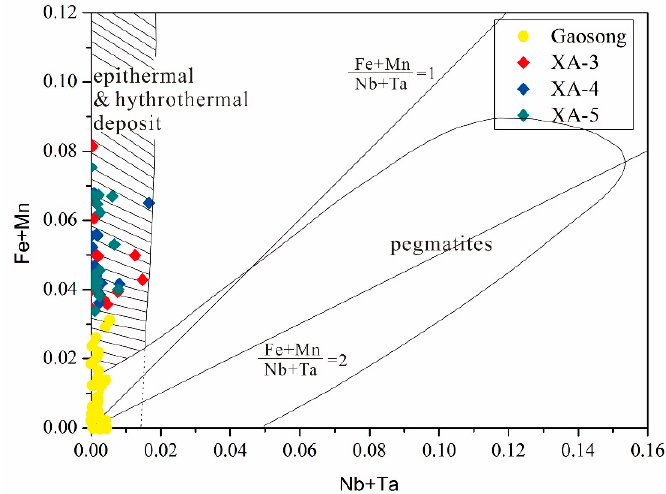
Figure 9. Covariation plot of Nb + Ta with Fe + Mn in cassiterite grains from the Xi’ao Cu-Sn deposit (EPMA data) (modified from [14]).